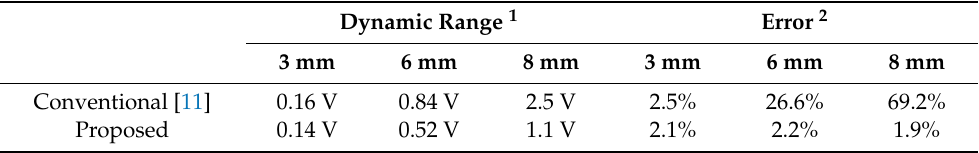
Figure 6. Conventional design results. ( a – c ) are waveform design results for 3 mm, 6 mm, and 8 mm lengths. ( d – f ) are SPICE verification results for 3 mm, 6 mm, and 8 mm lengths. Table 1. Comparison summary of single-line design results.